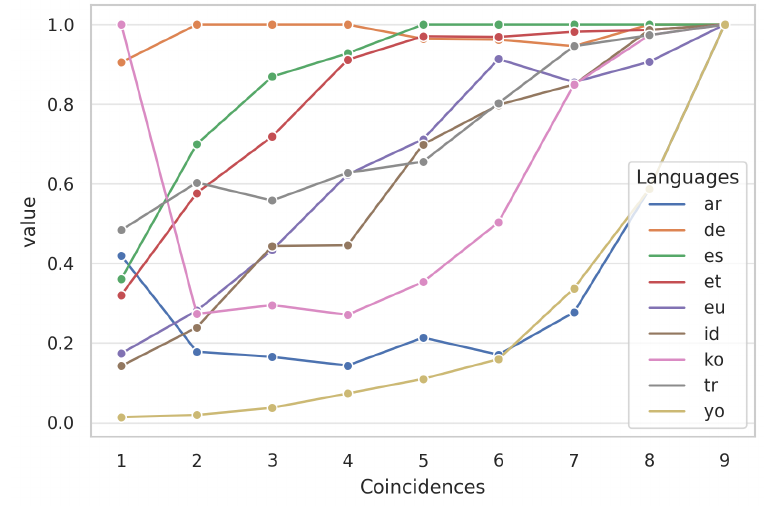
Figure 6. Distribution of the weighted rules per set of